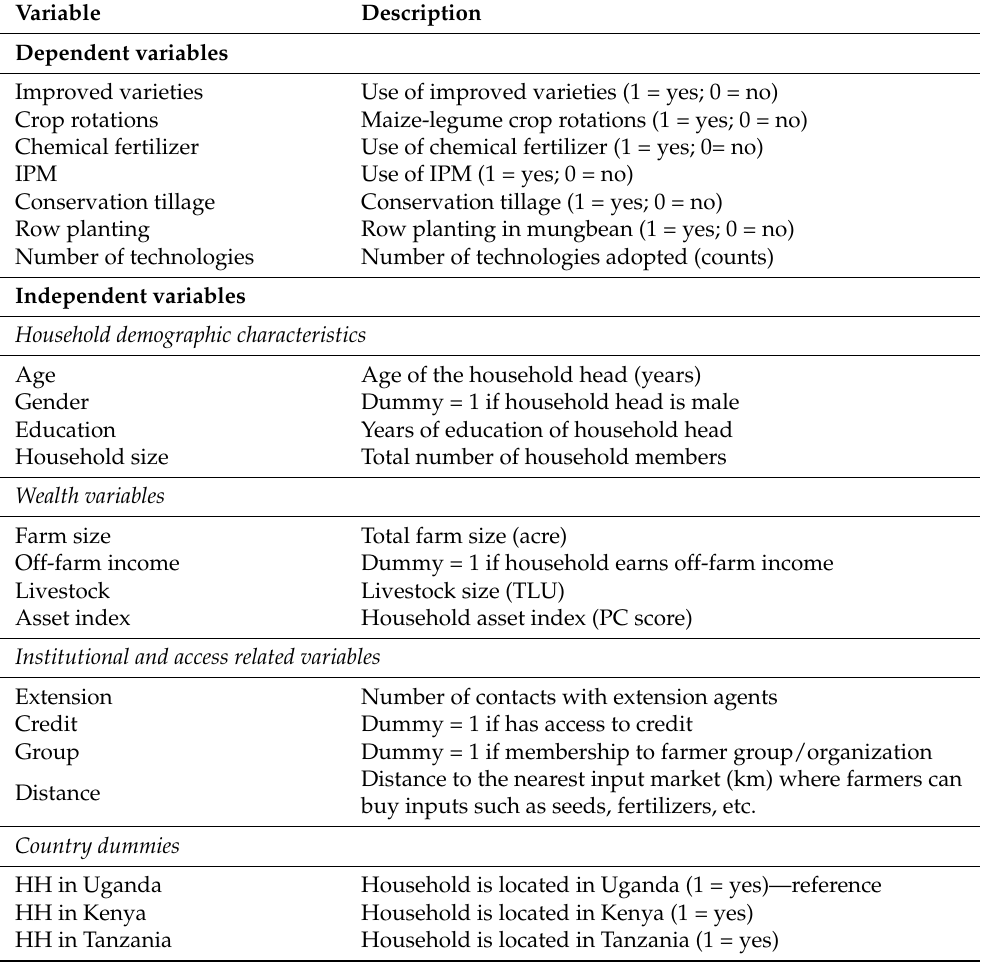
Table 2. Definition of variables used in the